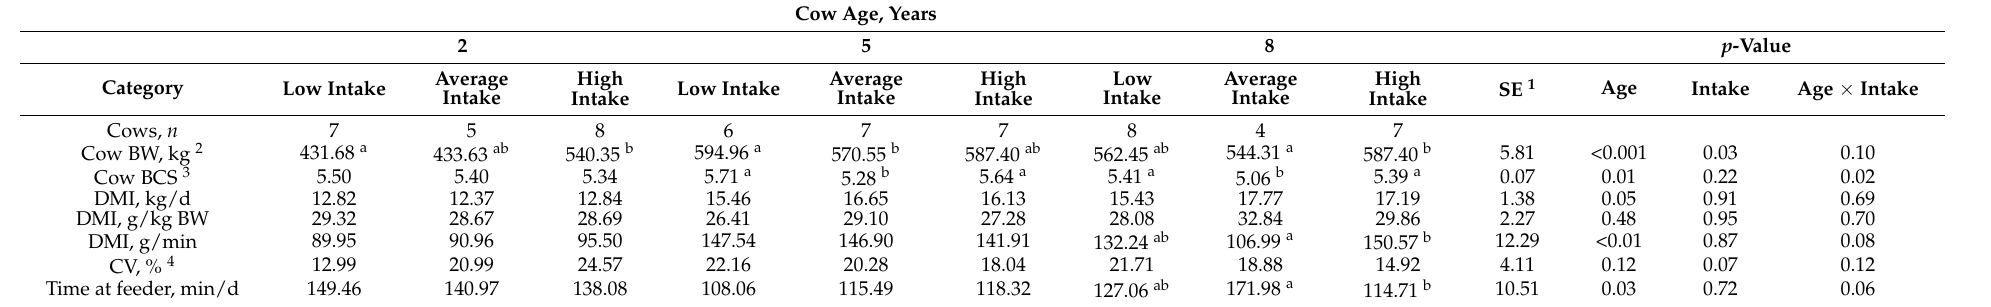
Table 1. The influence of heifer post-weaning intake expressed as grams per kg of body weight on subsequent beef cow performance of three age classes of pregnant, non-lactating beef cows (Study